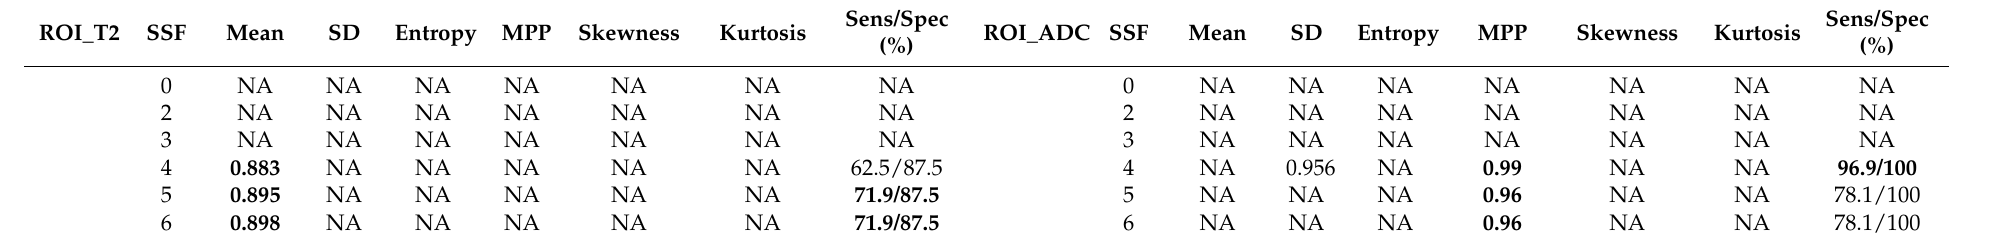
Table 3. MRTA analysis of partially necrotic ( ≥ 1/3 necrosis) tumours (PCNSL n = 8, GBM =